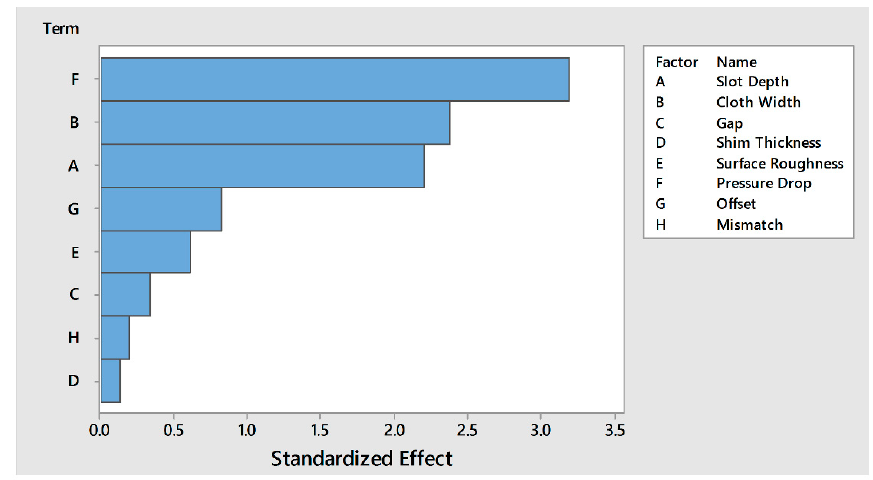
Figure 9. Pareto chart for normalized leakage rate (screening experiments).